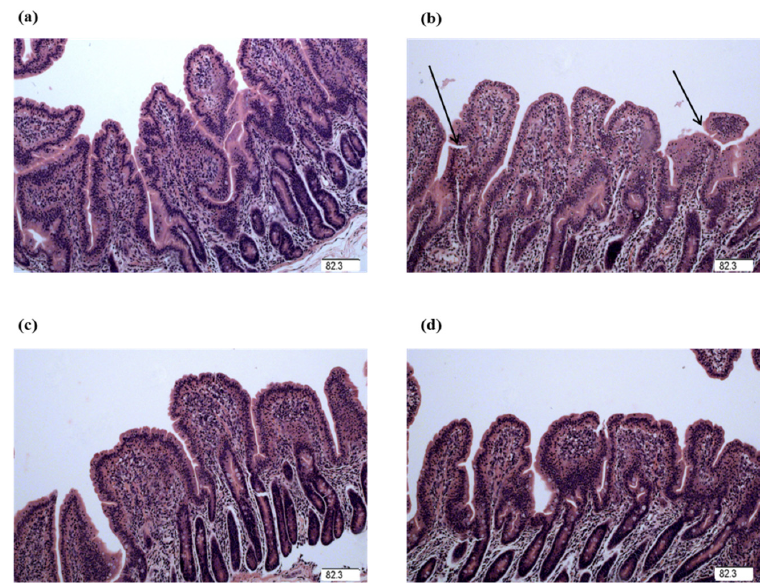
Figure 1. Jejunal mucosal histological appearance (hematoxylin and eosin). ( a ) Pigs fed a control diet and injected with sterile saline. No obvious damage was observed. ( b ) Pigs fed a control diet and injected with LPS. Intestinal mucosa was seriously damaged by LPS. Arrow represents the damaged intestinal mucosa in the piglets. ( c ) Pigs fed a 1.0% Gly diet and injected with LPS. Intestinal damage was alleviated. ( d ) Pigs fed a 2.0% Gly diet and injected with LPS. Intestinal damage was alleviated. Original magnification 100×. Scale bars = 82.3 μ m.